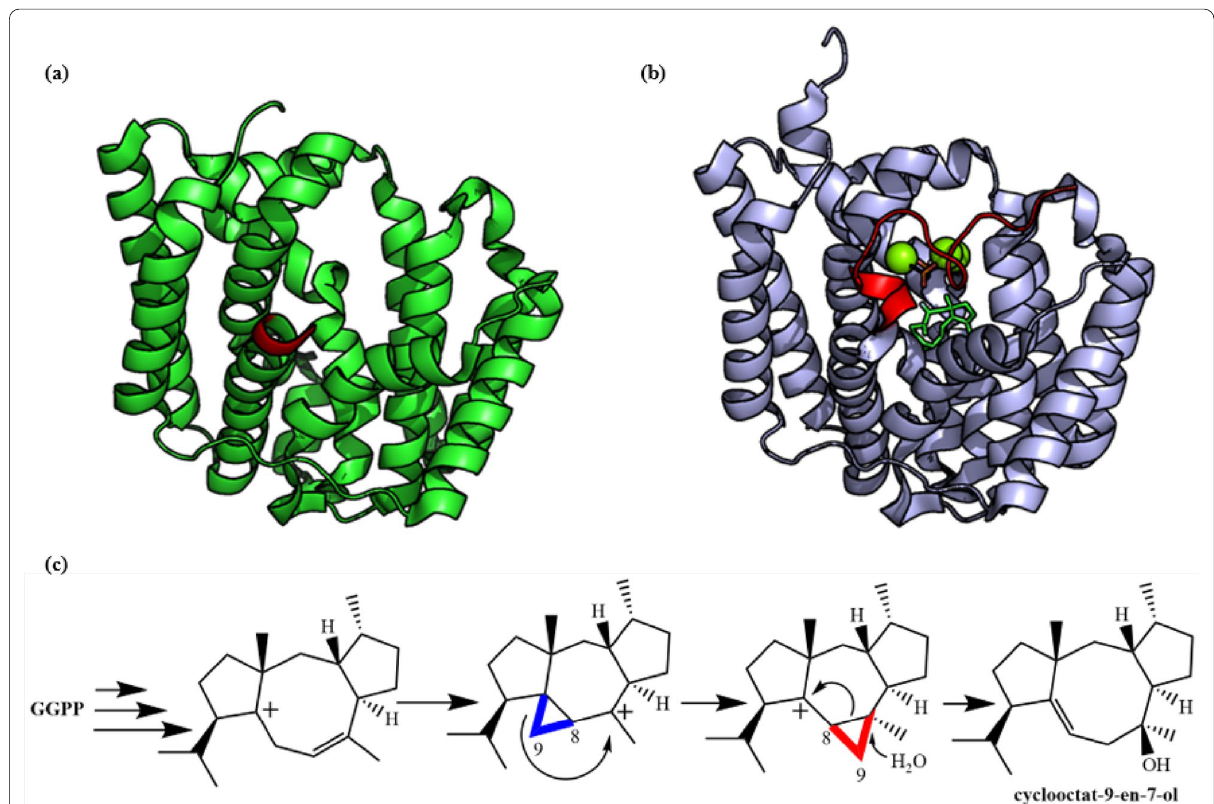
Fig. 15 Structure and function of CotB2. a Crystal structure of the bacterial diterpene cyclase CotB2 (PDB ID: 4OMG ). C‑Terminal is in red. b Crystal structure of CotB2 in complex with 2‑fluoro‑3,7,18‑dolabellatriene (PDB ID: 6GGI ). C‑Terminal is in red. c Reaction catalyzed by